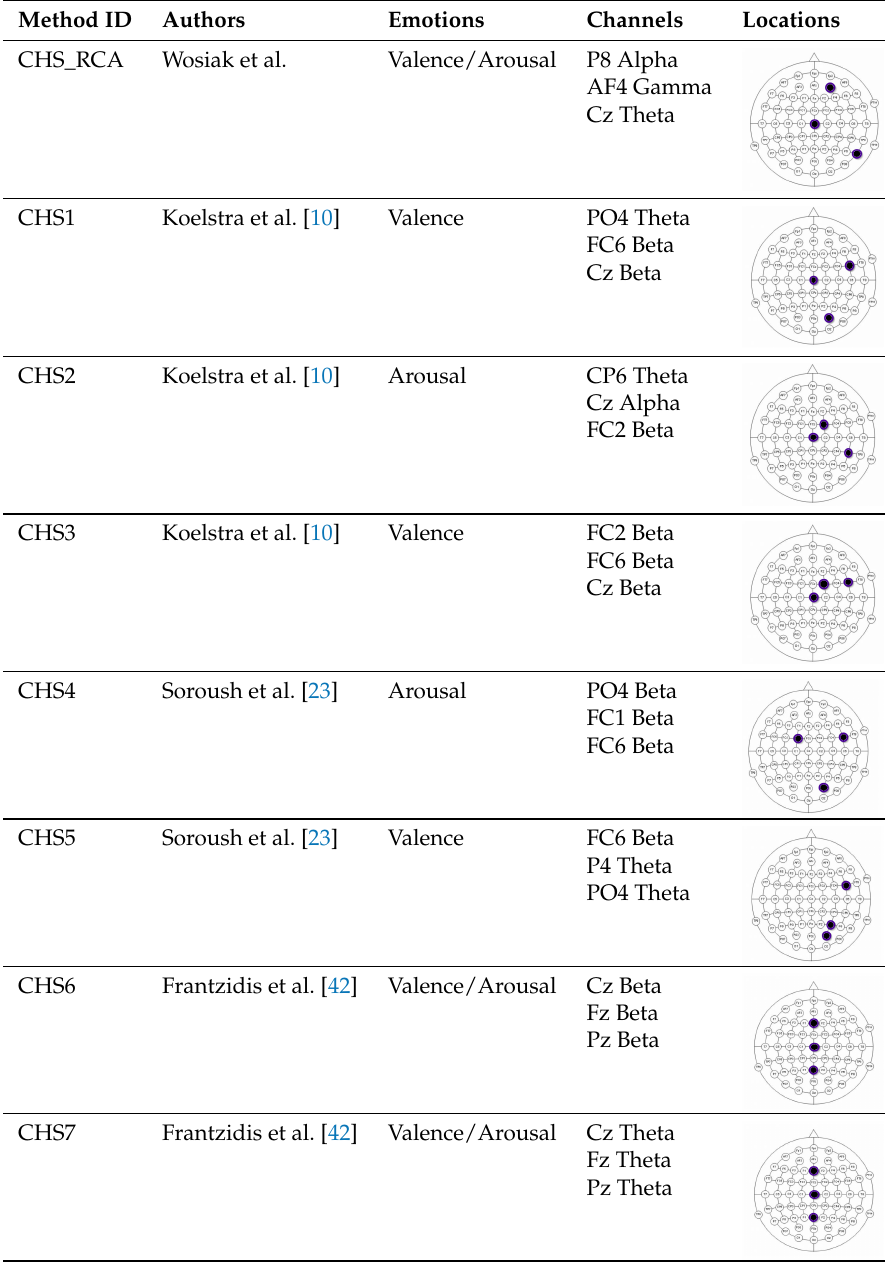
Table 3. Channel